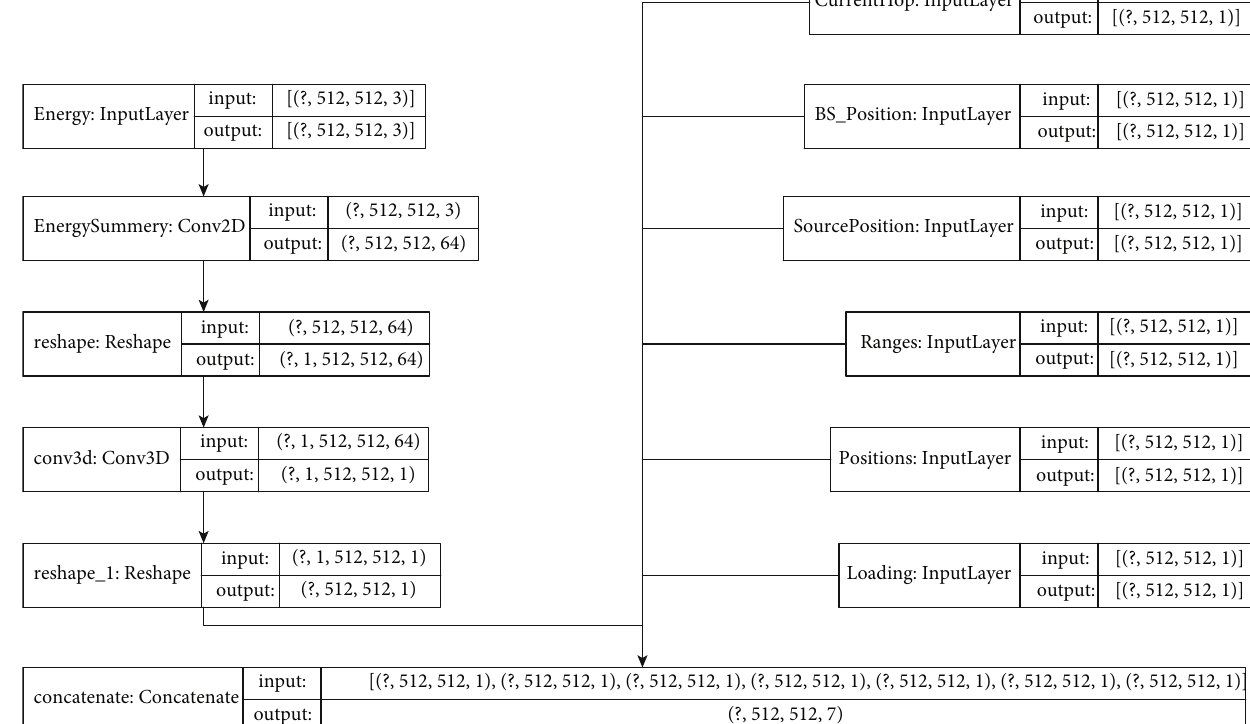
Figure 8: Processing of the energy array and concatenation with the remaining